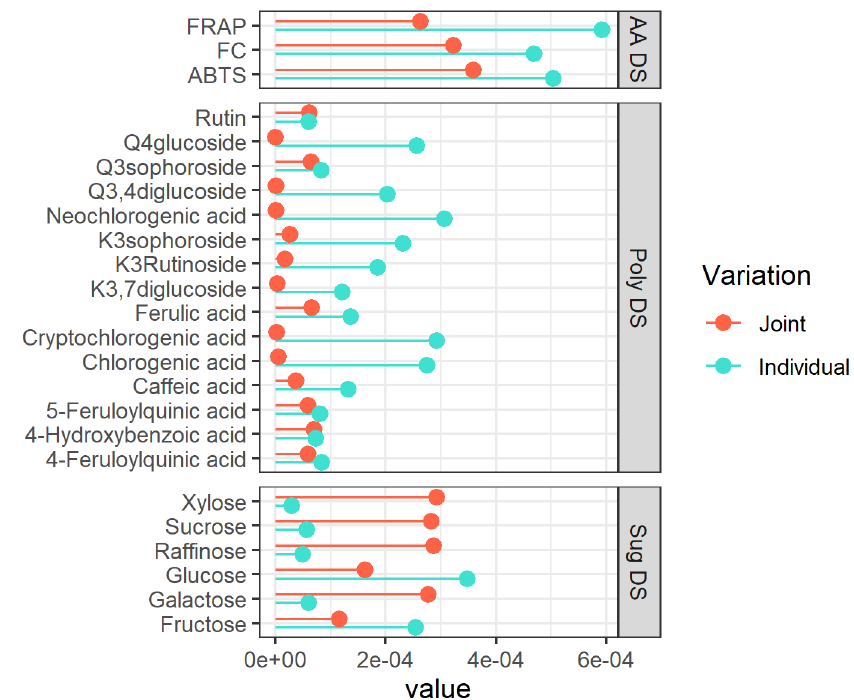
Figure 2. Variable importance (VIP) for each metabolite of the individual (turquoise lines) and Joint (tomato lines) parts. The VIP is calculated based on the rank extracted from the JIVE results. The ranks are 1, 3, 1 for the three separated datasets (AA, poly, and sug), respectively, whereas the joint part has a rank equal to 1 (see Section 2.11). AA = antioxidant activity, Poly = single polyphenols, Sug = sugars, DS = dataset, K = Kaempferol, Q =